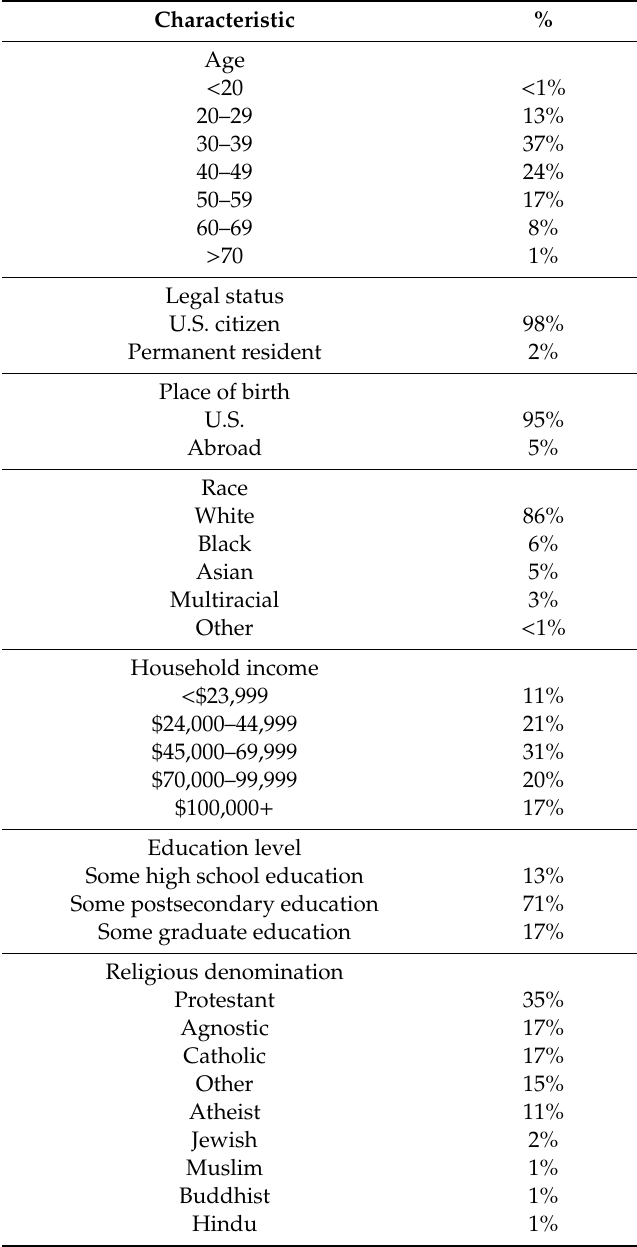
Table 1. Demographic